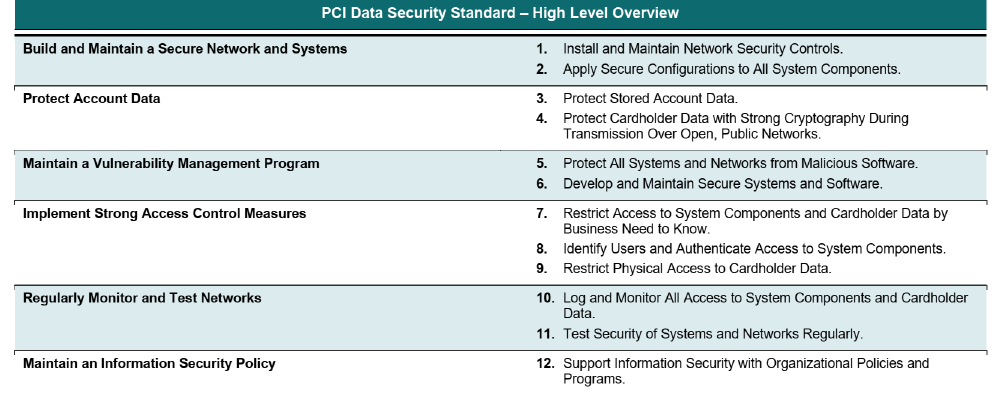
Figure 3. PCI DSS security goals and 12 principal requirements for the protection of cardholder data [39].